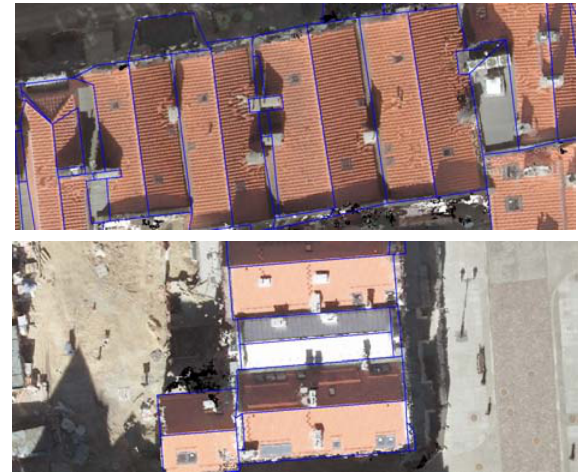
Figure 3. Examples of automatically generated 3D models of buildings with true-ortho from aerial images in a background. Ridge lines of selected building were also independently digitalized form true-ortho. The displacement between the corresponding roofs ridges from both data source were calculated as distance in normal direction (perpendicular to the direction of ridge line). The vector of displacement was computed in least-squares adjustment in order to minimalize squares sum of normal distances between the corresponding ridge lines. The alignment procedure was performed four times: three individually for each of scanning strip and one for all scan lines all together.